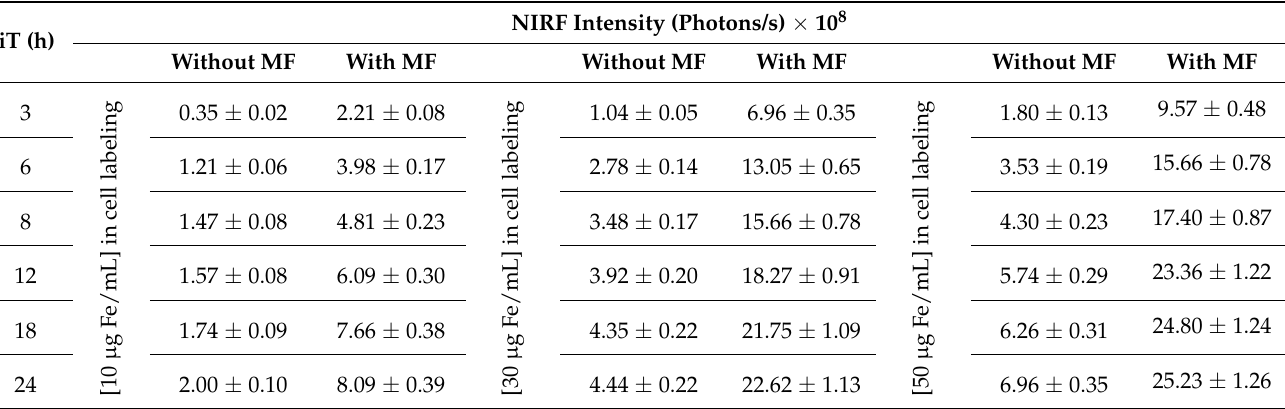
Table 2. The iron load quantification MFNP internalized into hBM-MSC by the NIRF signal intensity using different labeling